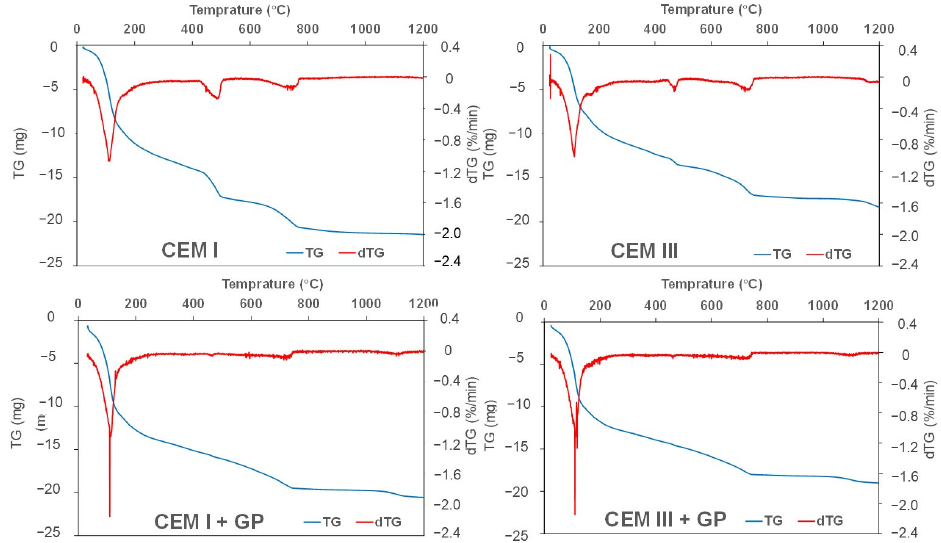
Figure 10. TG and dTG curves of the studied mortars.